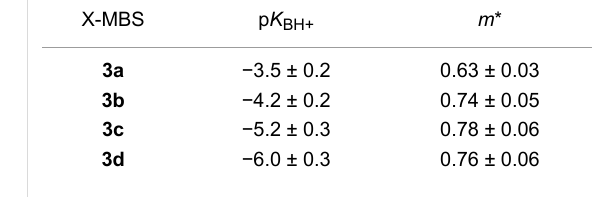
Table 1: Obtained p K BH+ and m * values for different para -substituted N